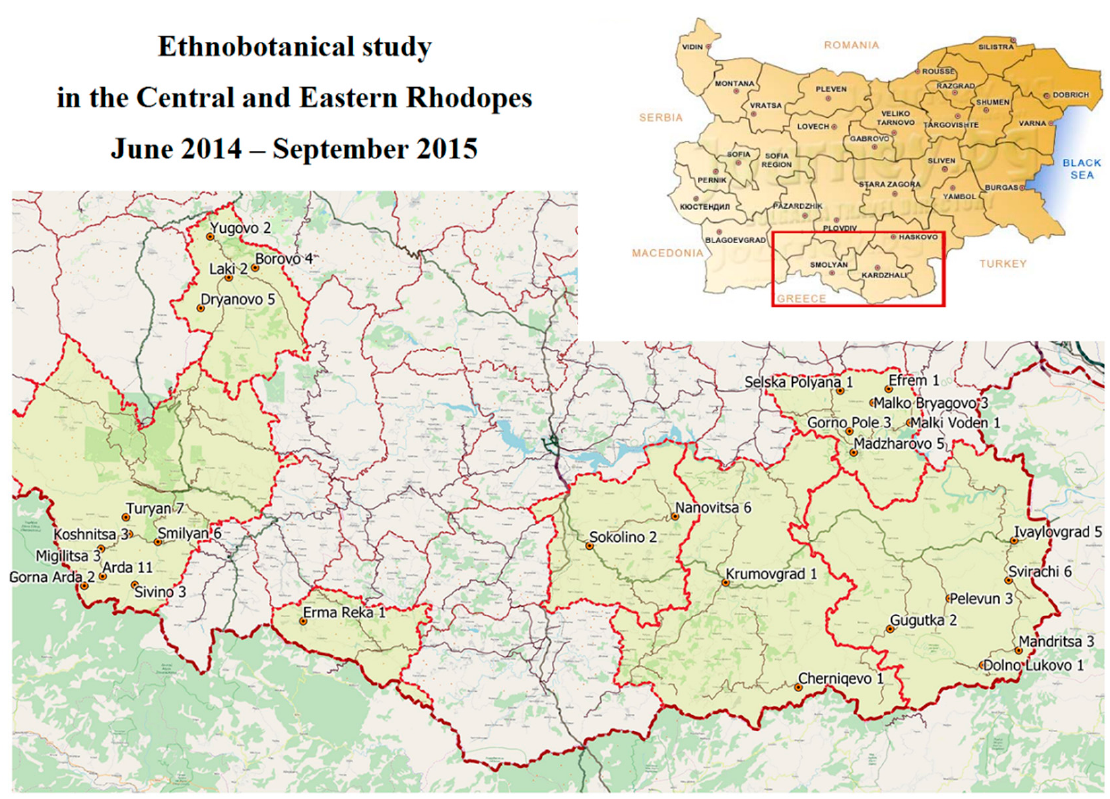
Figure 1. Settlements of the survey in the Rhodope Mountain and the number of